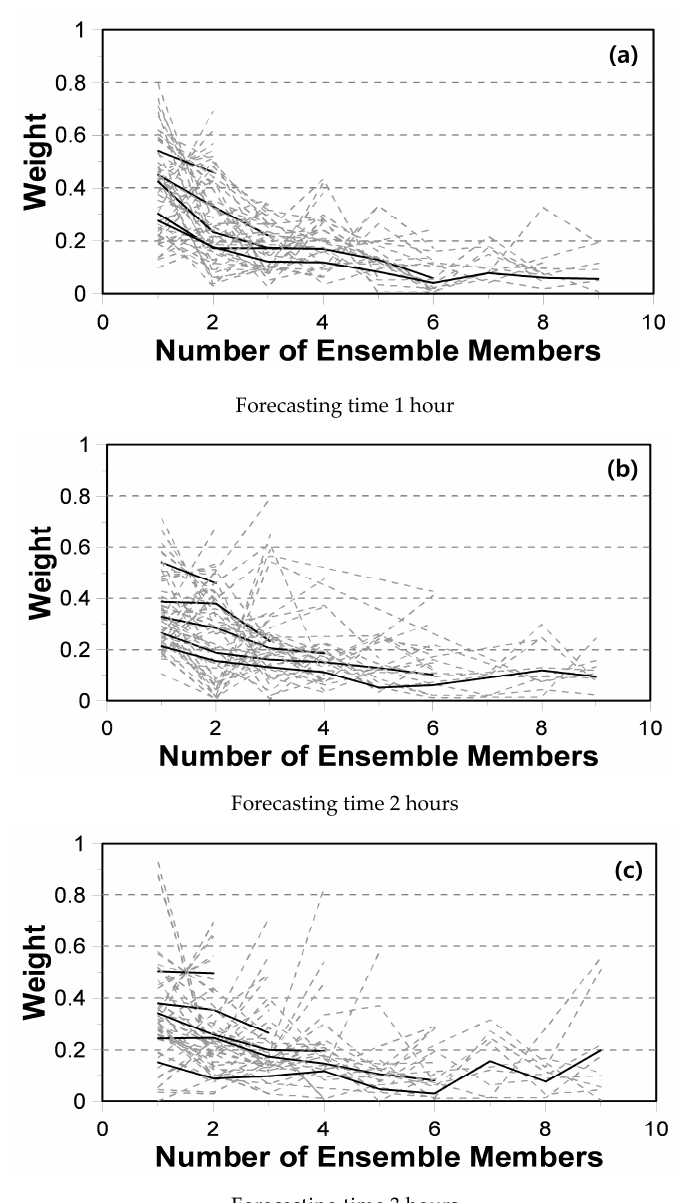
Figure 5. Final weights determined from the 10 different target times for the cases with the numbers of ensemble members 2, 3, 4, 6, and 9.